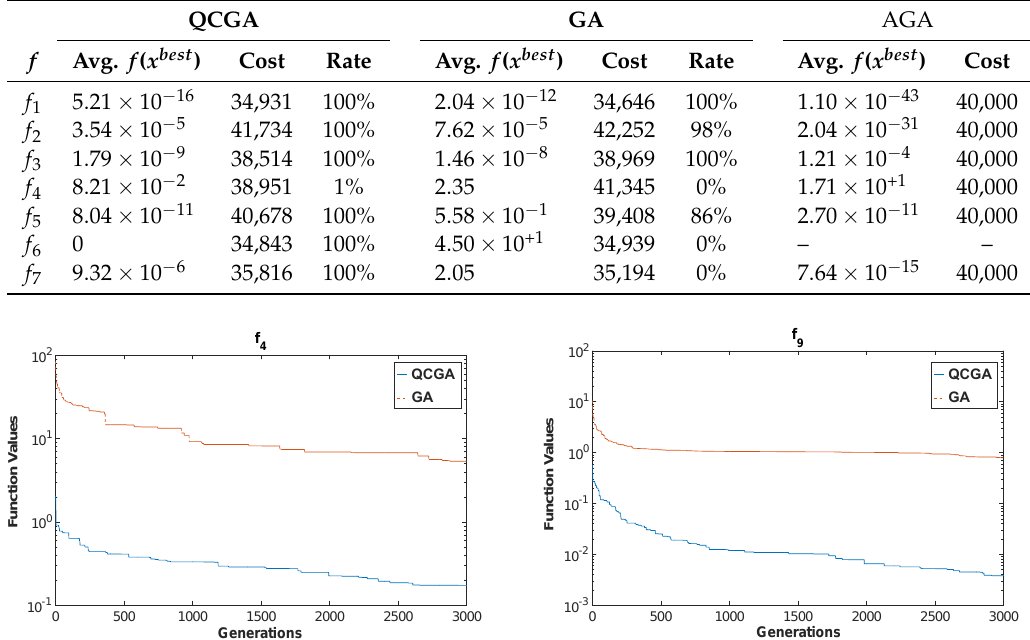
Figure 7. Examples of QCGA and GA performance using f 4 and f 9 test